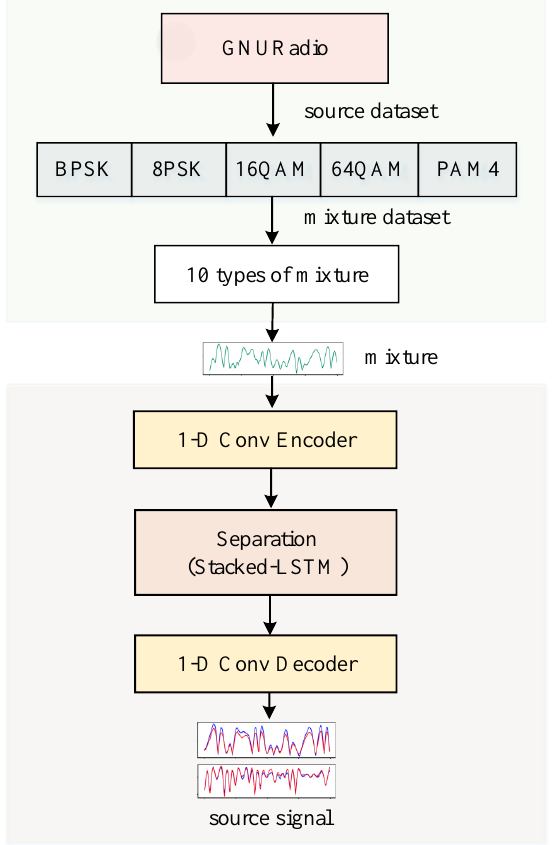
Figure 5. Experimental